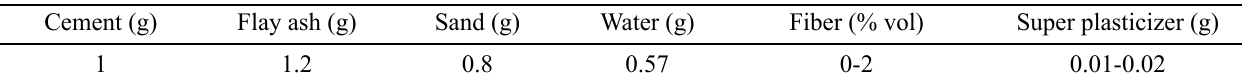
Table 3. ECC mix design proportions